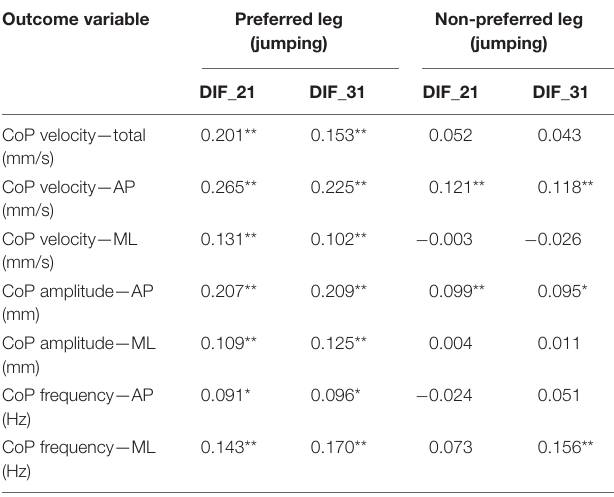
TABLE 1 | Correlations among whole-trial estimates and corresponding transient characteristics of body